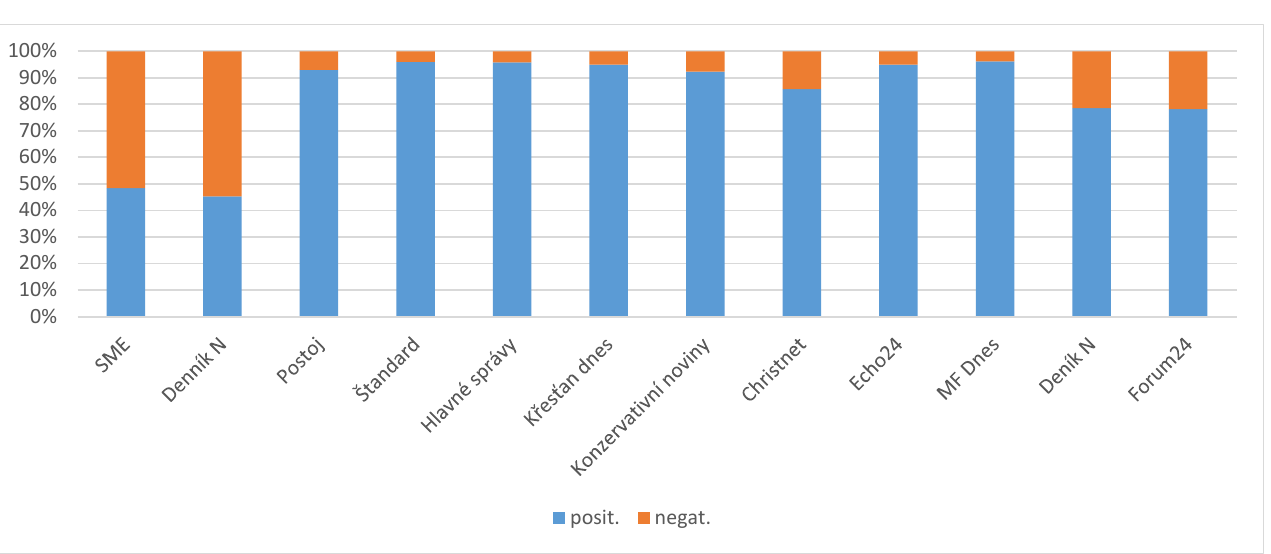
Figure 11. Overview of argumentation vectors by individual media.